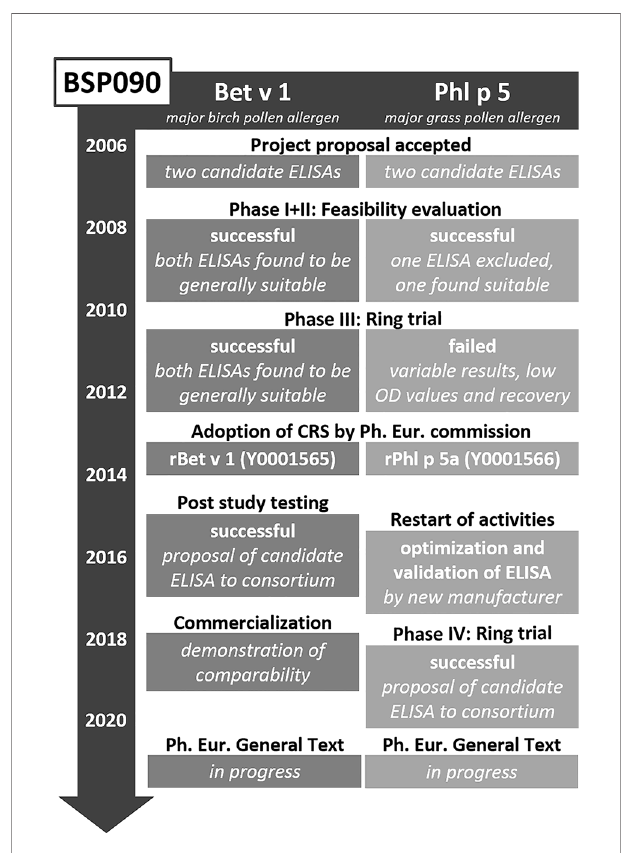
FIGURE 2 | Overview of the BSP090